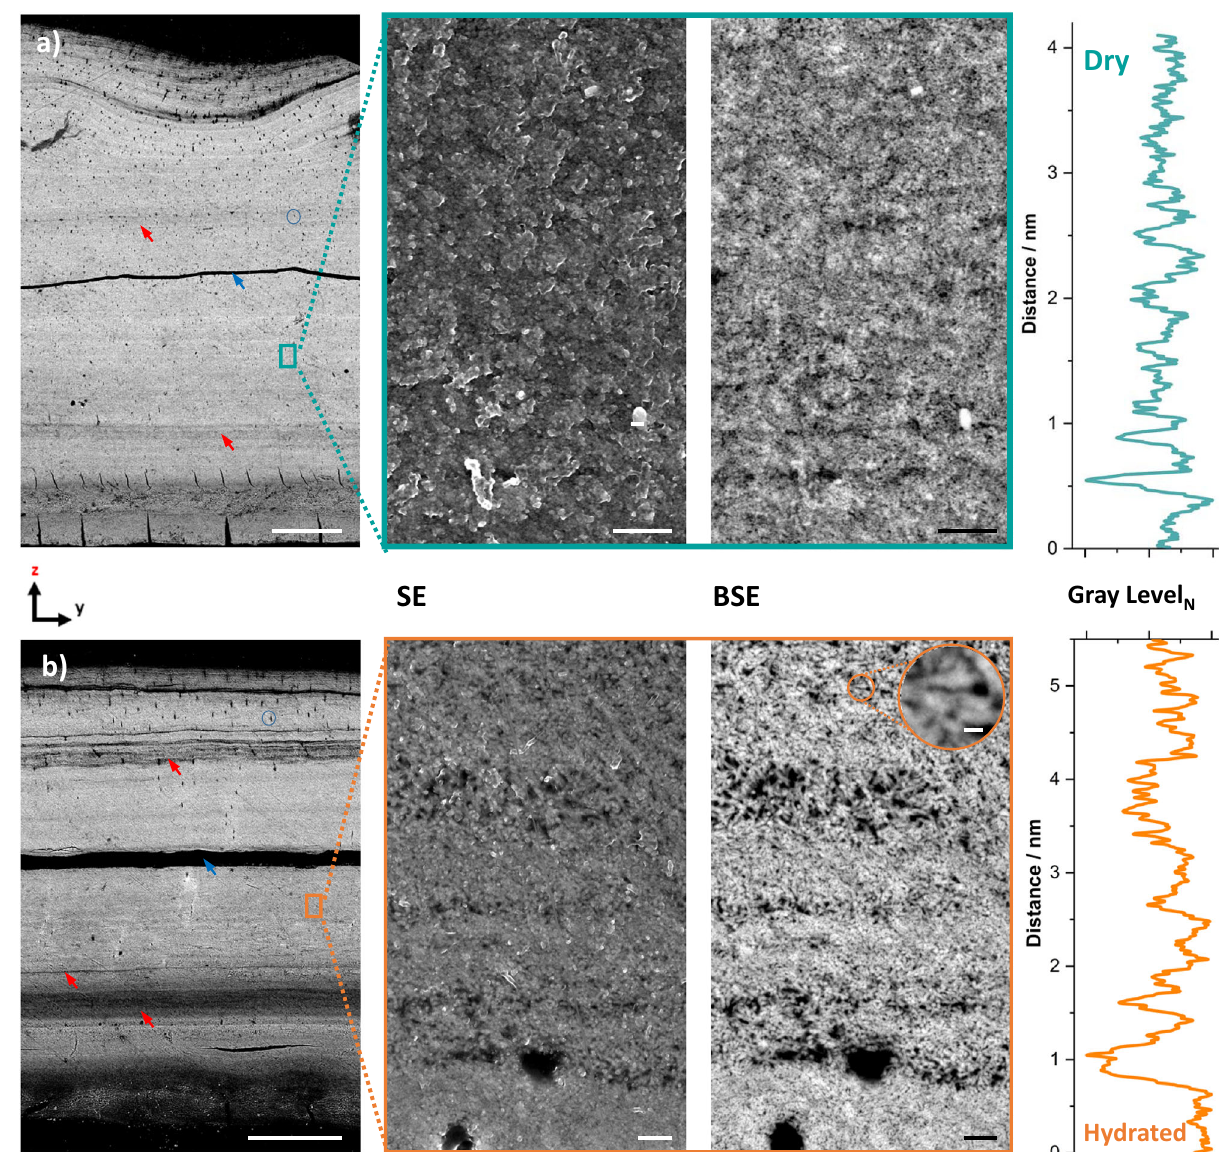
Fig. 4 Scanning electron microscopy of polished shell samples. Shown in the left panels are SEM-BSE cross-section micrographs of a a dry shell stored in air and b a fully hydrated shell fi xed with 4% formaldehyde. Blue arrows highlight fracture lines incurred during sample preparation. Red arrows are used to point out example areas of high organic content. Blue circles are used to indicate pores in the shell. Scale bars are 20 µ m. Provided in the central panels are images at a higher magni fi cation acquired either with secondary electrons (SE) to stress variations in morphology and surface topography or acquired with backscattered electrons (BSE) used to highlight compositional/elemental contrast. Scale bars are 200 nm. The inset highlights the francolite bundle dimension. The scale bar is 50 nm. In the far right panels are average line pro fi les of the grayscale within the colored boxes in ( a ) and ( b ), normal to the laminae direction. Source data for this fi gure are available at the University of Edinburgh DataShare, data identi fi er https://doi.org/10.7488/ds/3056 67